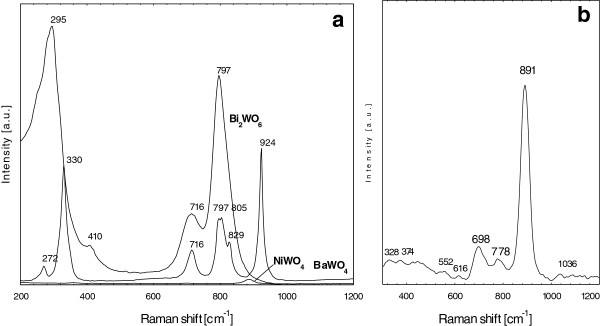
Raman spectra for the metal tungstates. (a) NiWO4, BaWO4 and Bi2WO (b) enlarged spectra for NiWO4.